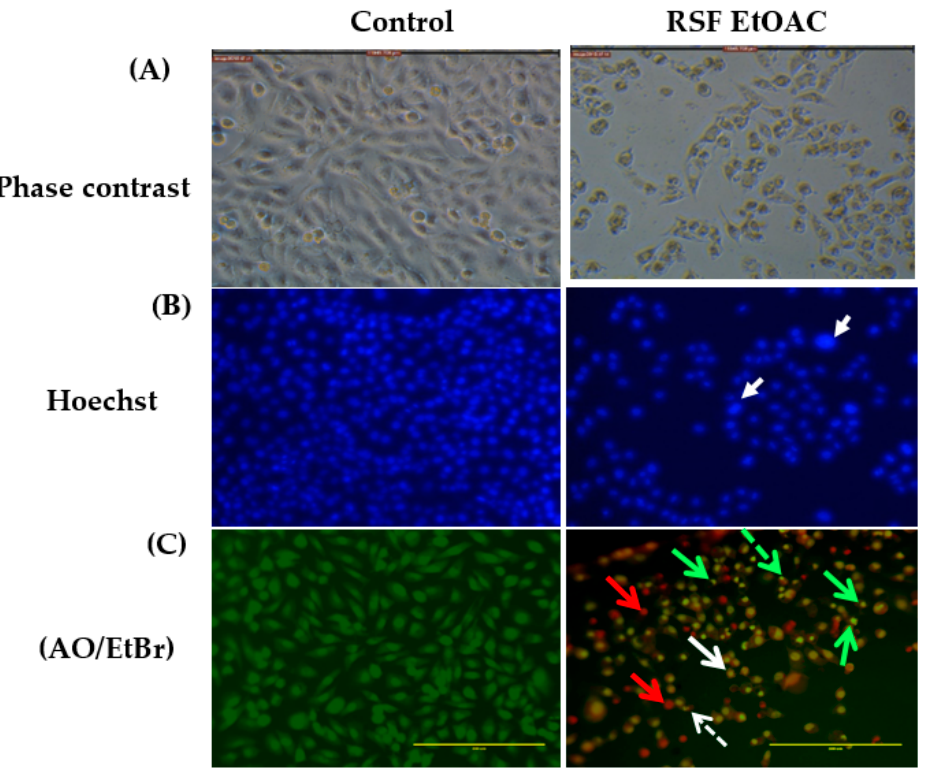
Figure 2. Detection of apoptosis in MDA-MB-231 cells after treatment with IC 50 RSF EtOAC extract. ( A ) Phase-contrast microscopy showed a significant decrease in the number of cells after treatment versus untreated cells. ( B ) Nuclear morphology changes in both control and treated cells assessed by Hoechst staining, arrows indicating apoptotic cells ( C ) Viable cells show green fluorescence while necrotic and apoptotic cells show orange and yellow fluorescence. A dotted arrow indicates fragmented nuclei, a regular arrow indicates membrane blebbing, a green arrow represents apoptotic cells, and a red arrow represents necrotic cells.